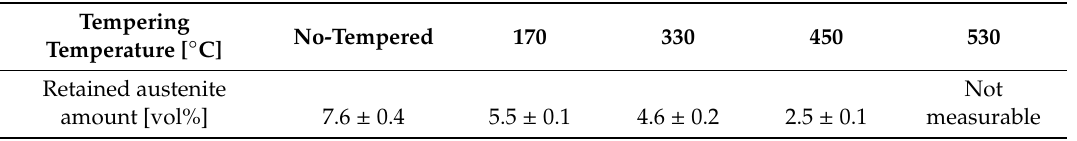
Table 3. Retained austenite amount (in vol%) in Vanadis 6 steel after quenching followed by sub-zero treatment at − 75 ◦ C for 17 h, no-tempered and tempered at di ff erent